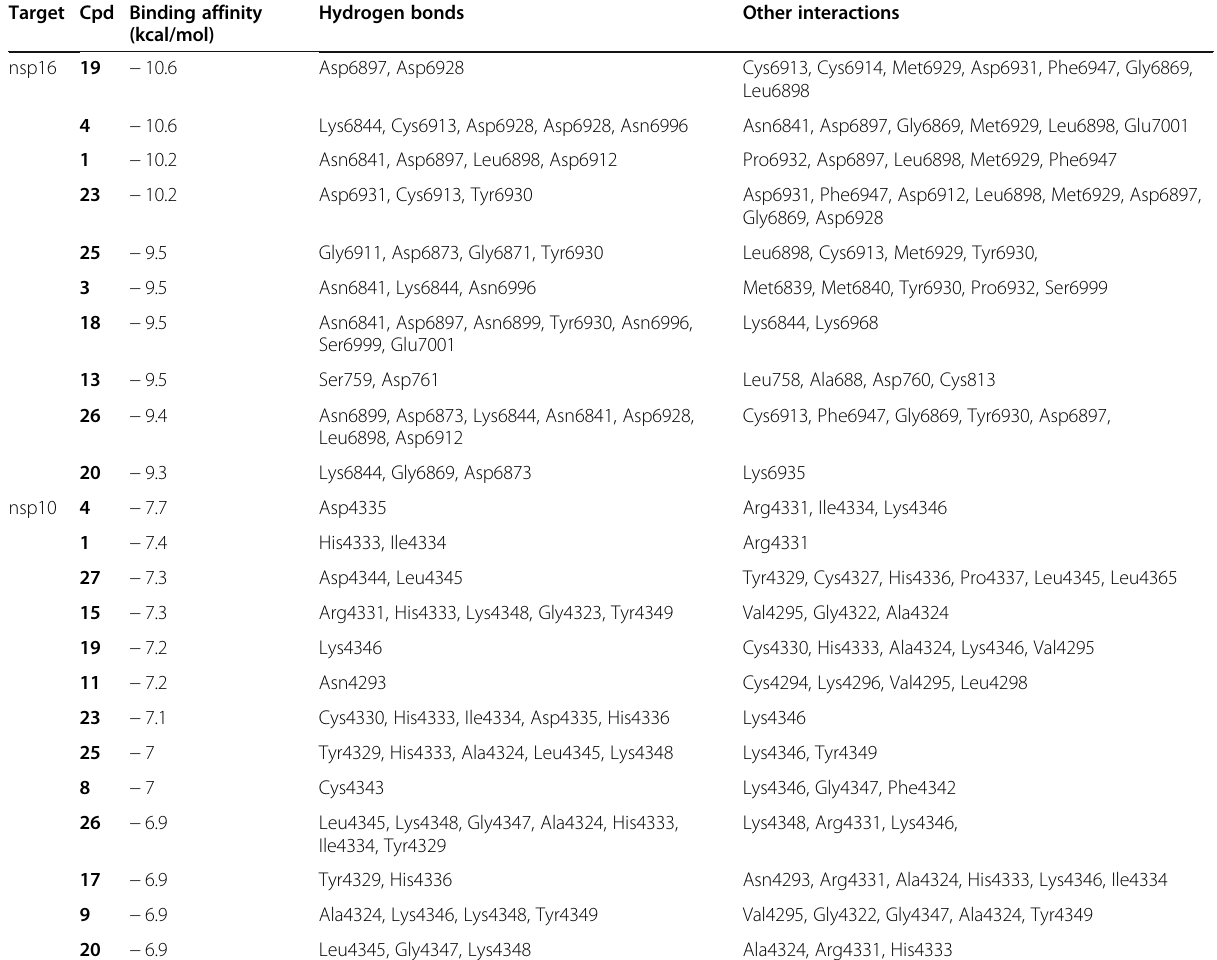
Table 3 Binding affinities and interactions of top ten ligands against the nsps of the SAM-dependent 2 ′ -O-methyltransferase complex Target Cpd Binding affinity Hydrogen bonds Other (kcal/mol)